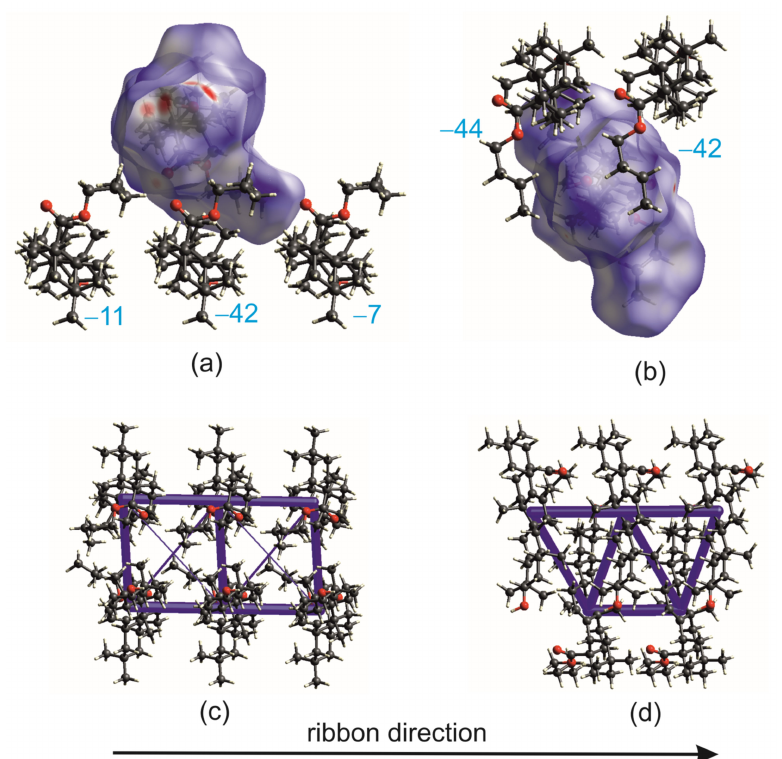
Figure 8. Intermolecular energies (kJ/mol) between molecules within the ribbon dimer and total energy frameworks in ( a , c ) R 3-but-OA and ( b , d ) P 2 1 -but-OA : in ( a , b ) for one molecule, Hirshfeld surfaces mapped with d norm are shown, and the energy values color match the color in Table S4. Interaction energies in ( c , d ) are shown as cylindrical tubes with diameters proportional to the magnitude of the